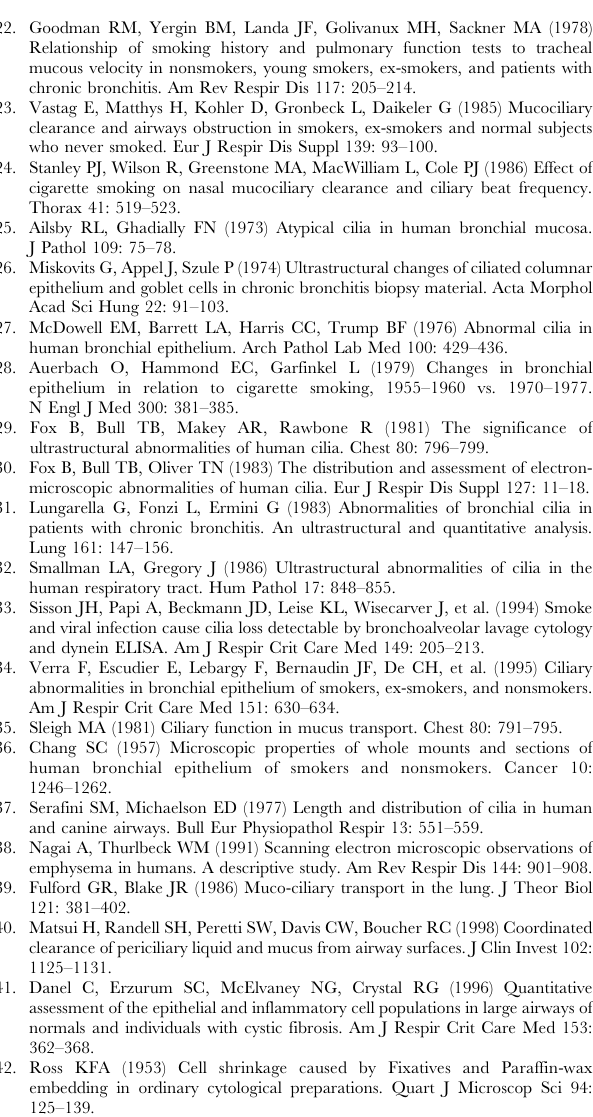
Table S1 Study Population for Large Airway Epithelial Gene Expression. Table S2 Cilia-Related Gene Expression in Airway